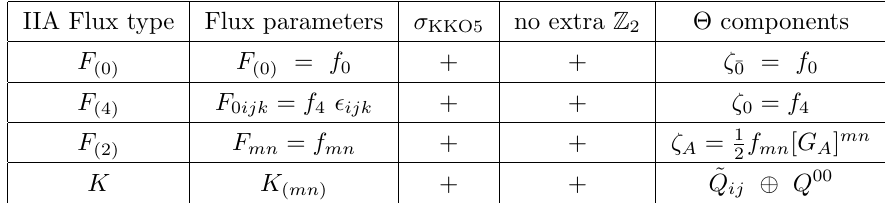
Table 8 . Critical points of the scalar potential induced by the compacti(cid:12)cation of mIIA with O8/D8. In this case, we obtain a 1-parameter family of solutions, which induces a Minkowski-type universe.